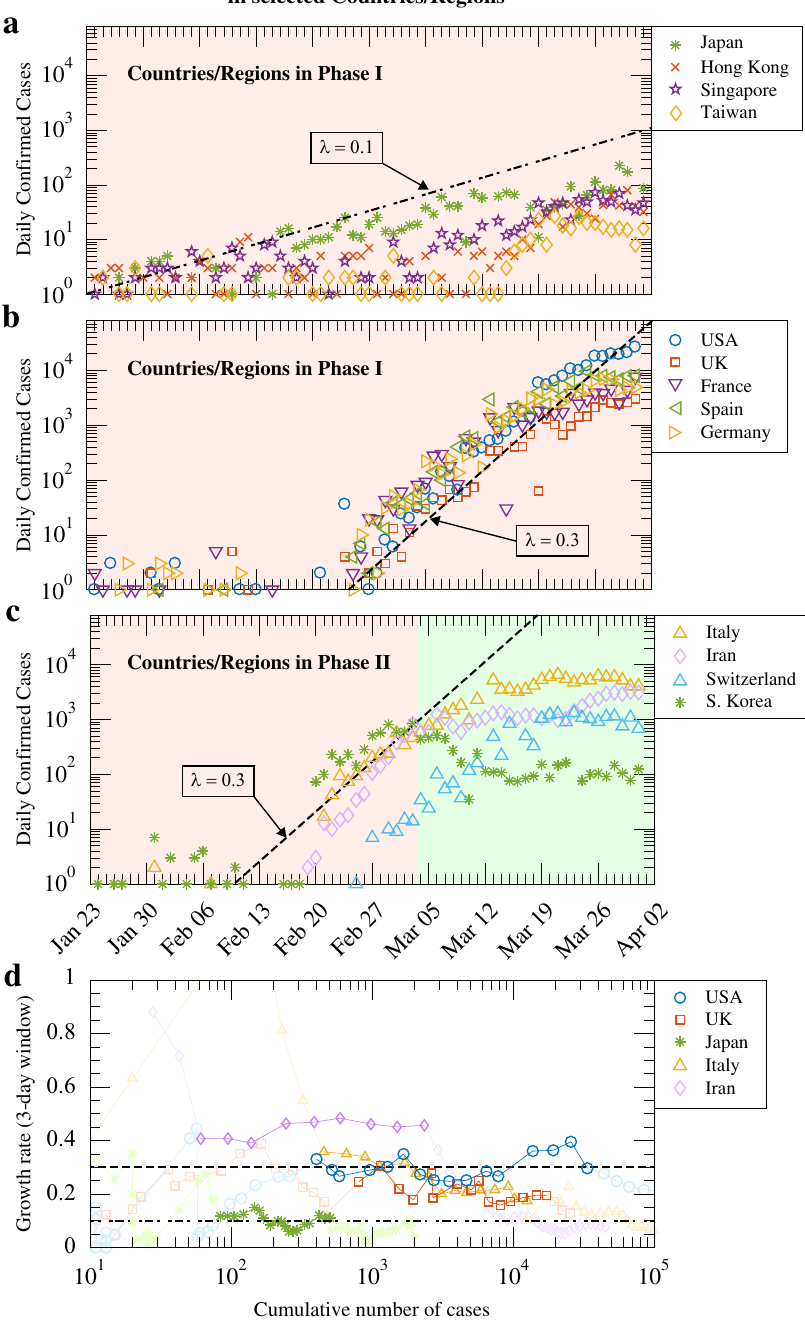
Fig. 6 First wave of the COVID-19 pandemic in selected countries and regions. a – c The number of daily con fi rmed cases from late January till end of March 2020. Countries/regions in a were successful in keeping transmission at a low level while those in b experienced exponential growth of local cases. Countries/regions in c have entered or been in the middle of phase II. Italy, South Korea, and Switzerland have reached zero or negative growth in daily con fi rmed cases, while data from Iran indicates a slowing down of the exponential growth. d The estimated epidemic growth rate λ ( T ) against the cumulative number of con fi rmed cases N ( T ) in fi ve representative countries. Dashed and dashed-dotted lines indicate the exponential growth rates of 0.3/ day and 0.1/day,